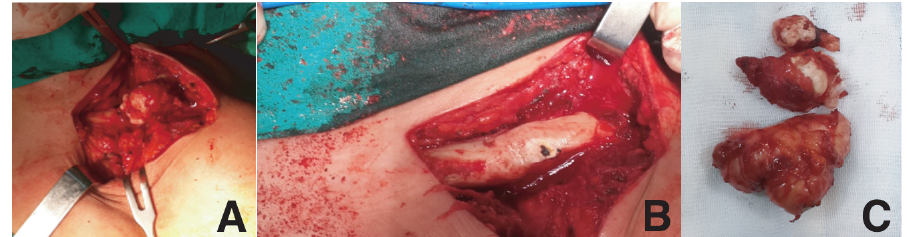
Figure 3 : (a) Intraoperative view of the antero-superior part of the left mid-clavicular parosteal osteoma. (b) Same view after marginal resection. (c) Bone fragments excised with reduction surgery.